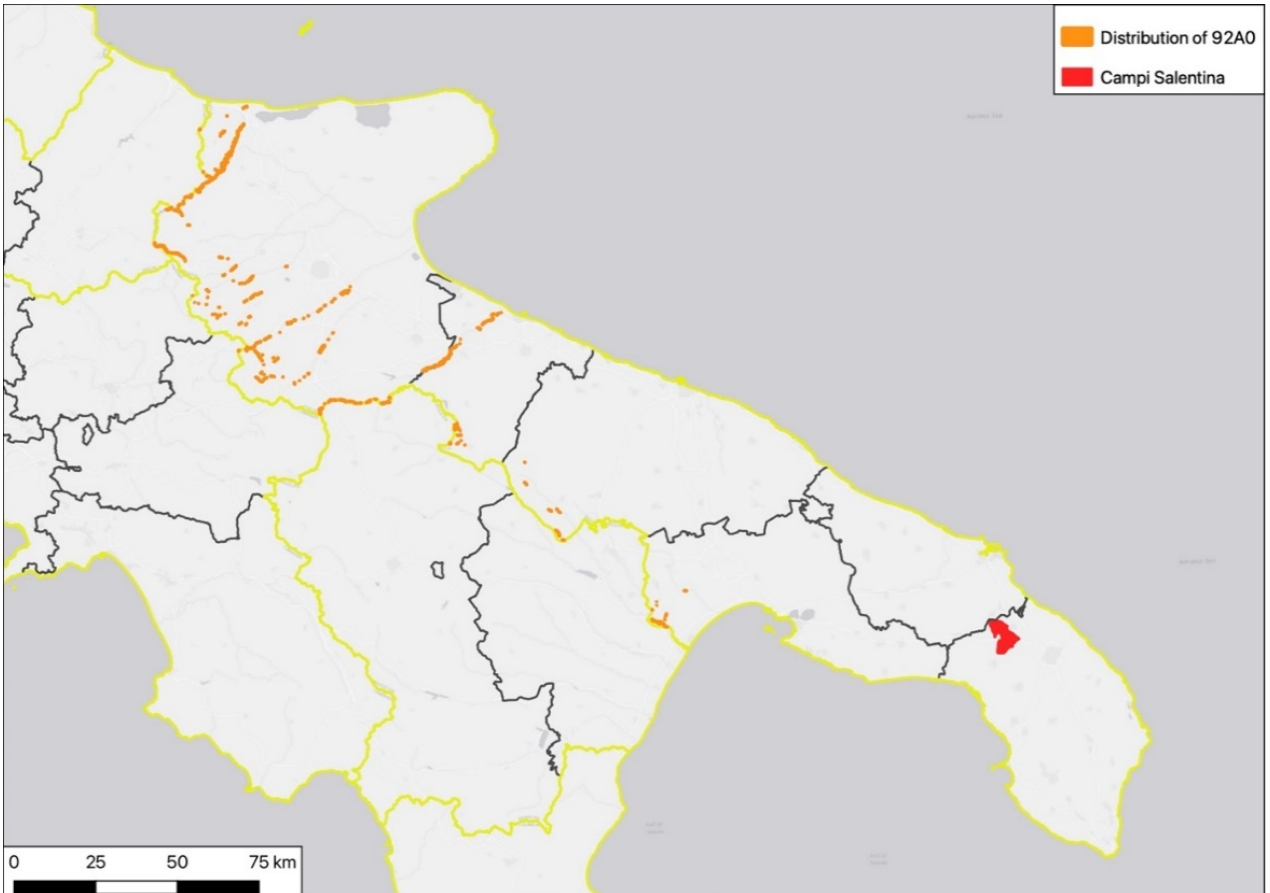
Figure 5. Distribution of Salix alba and Populus alba galleries in the Puglia Region [45].